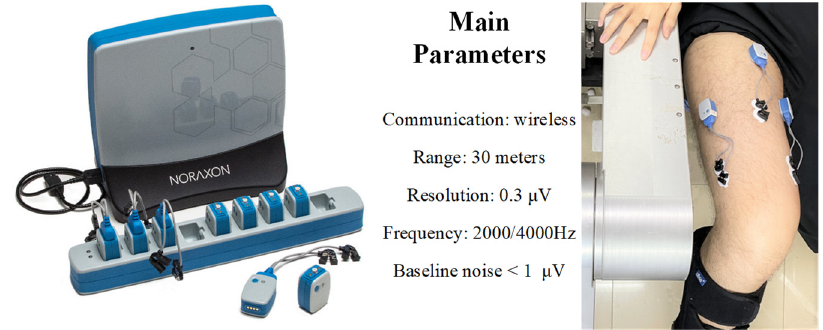
Figure 9. Parameters of EMG device and electrode patch positions.